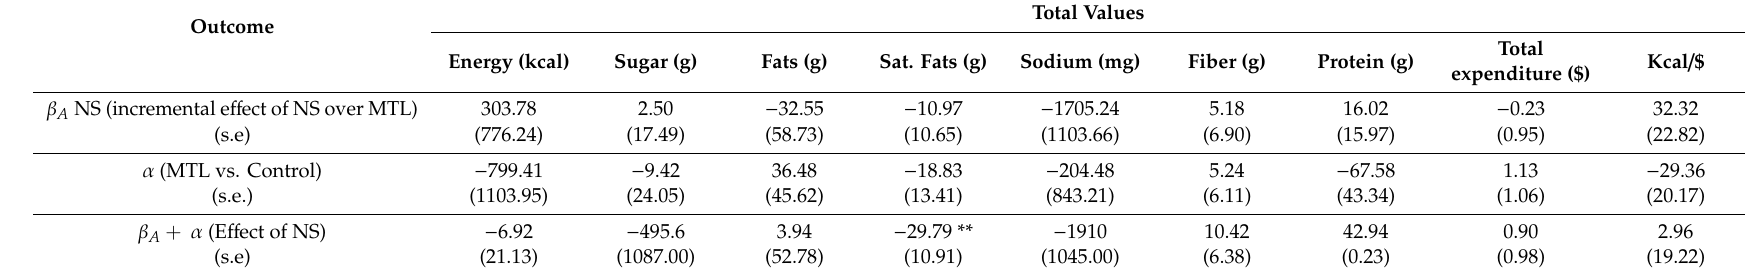
Table A4. Regression for foods only with total values and cost as outcome ( N = 287, n =